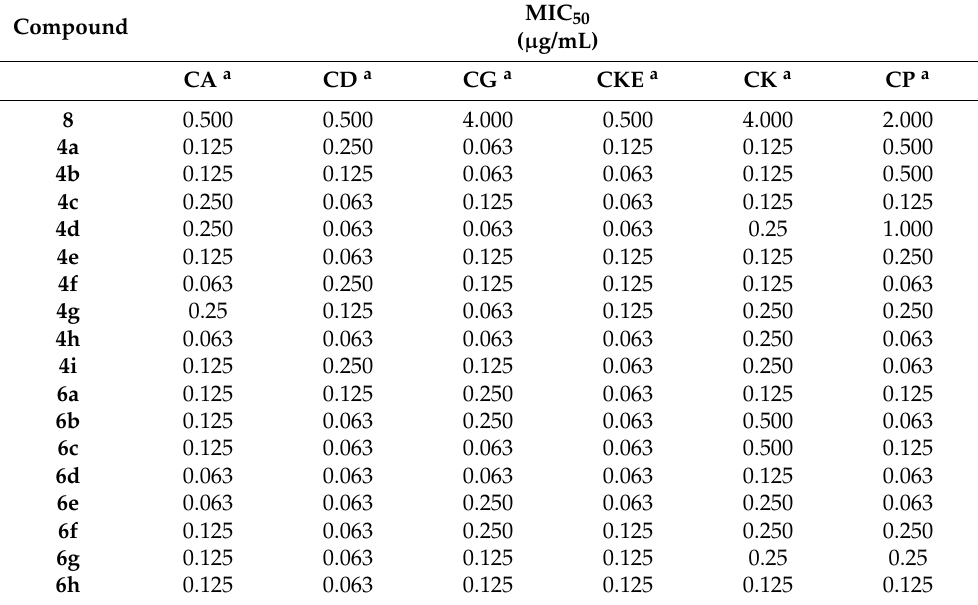
Table 7. Antifungal activity against Candida spp. by 2-amino-3-cyano-4 H -chromenes 4a – i and 6a – h and fluconazole ( 8